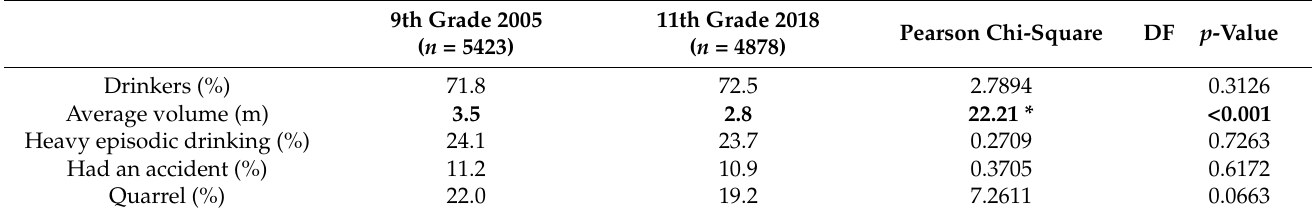
Table 1. Comparison of measures of drinking: 9th grade students in 2005 and 11th grade students in